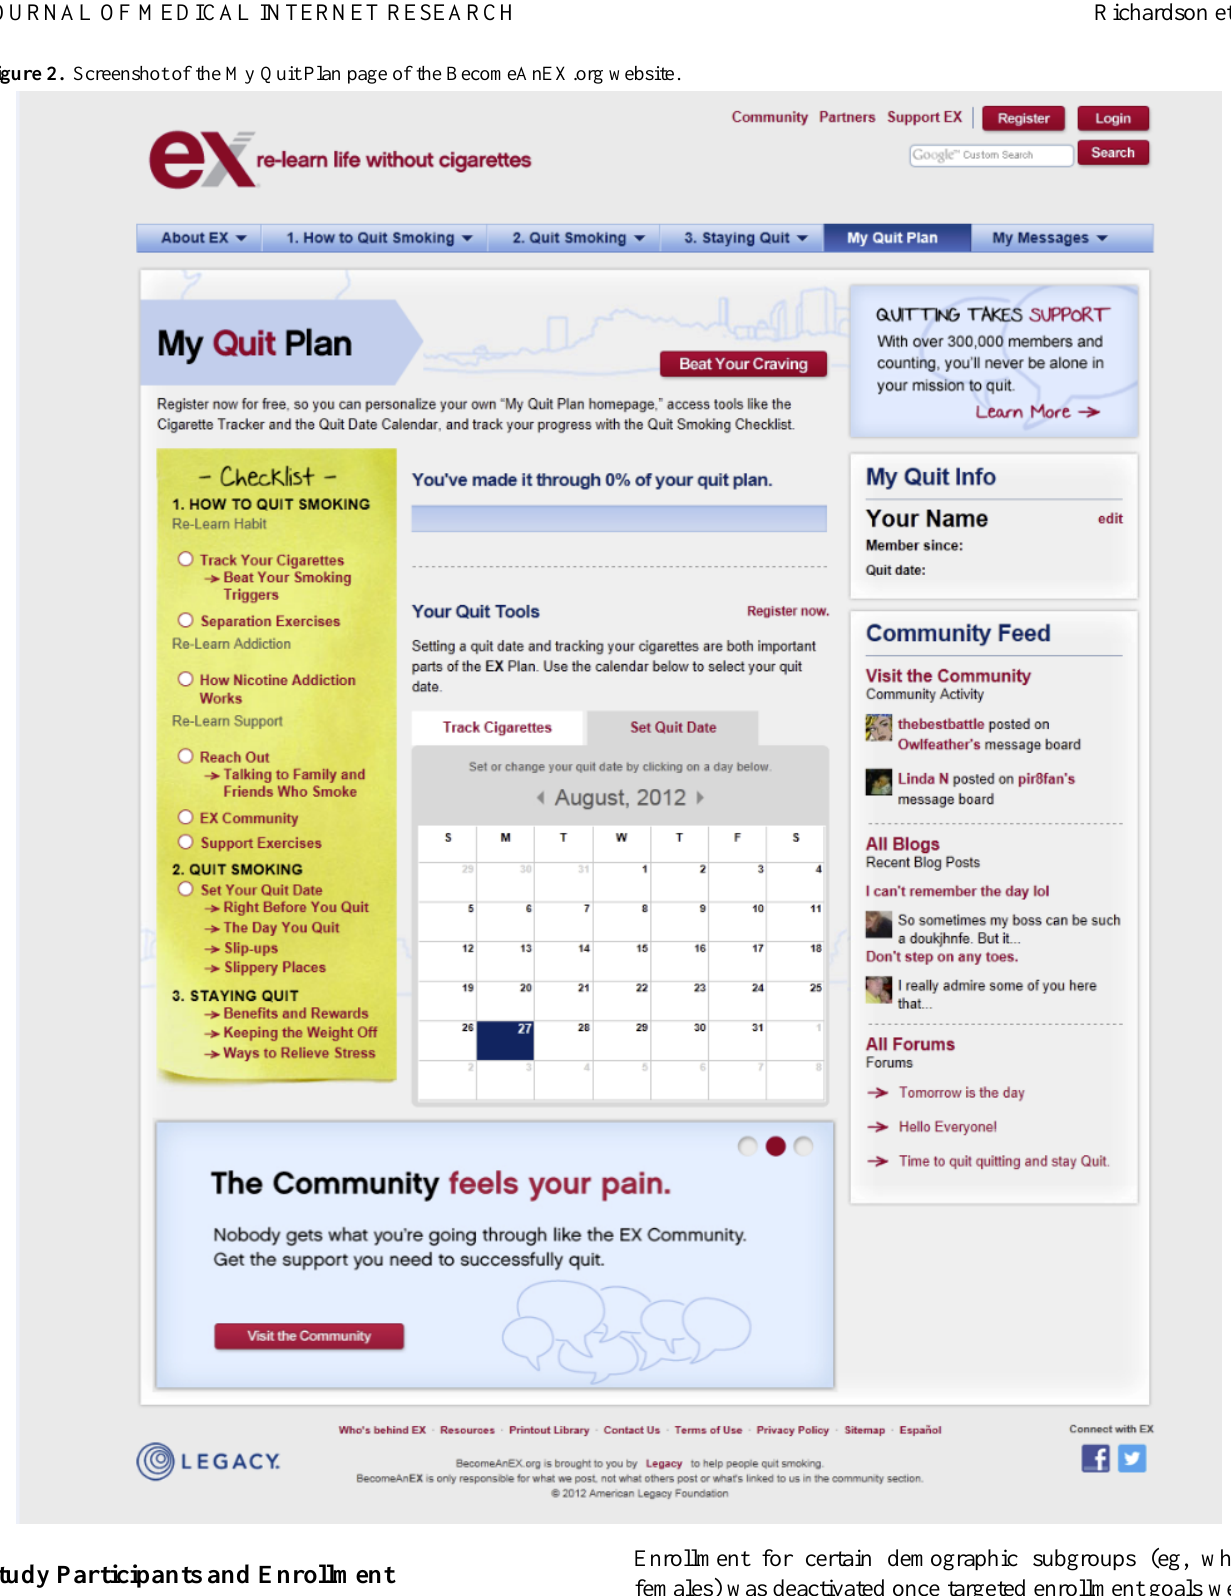
Figure 2. Screenshot of the My Quit Plan page of the BecomeAnEX.org